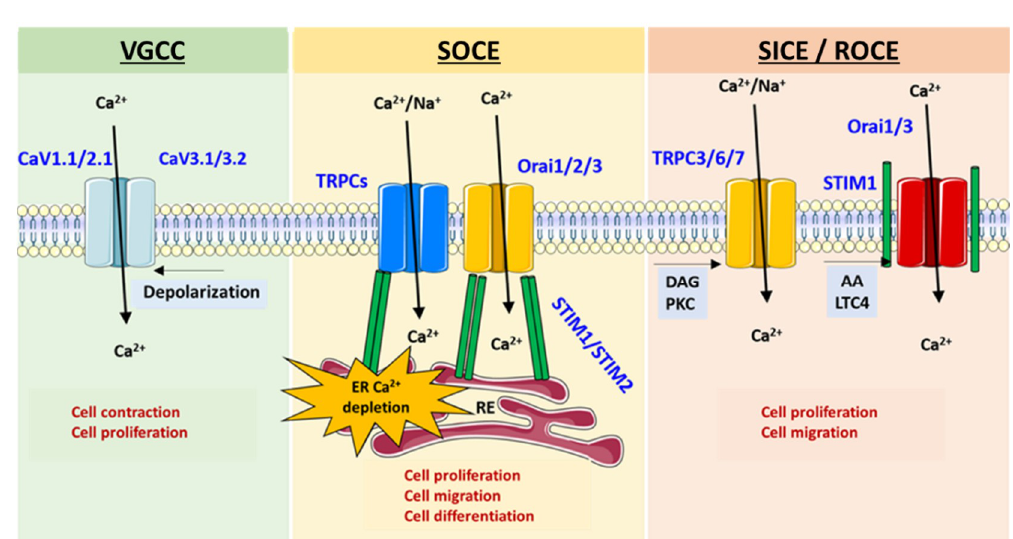
Figure 5. Coexistence of Voltage-Gated Ca 2+ Channels (VGCC), non-voltage-dependent Store-Operated Ca 2+ Entry (SOCE) and non-voltage-dependent Store-Independent Ca 2+ Entry (SICE or ROCE) in mammalian cells.